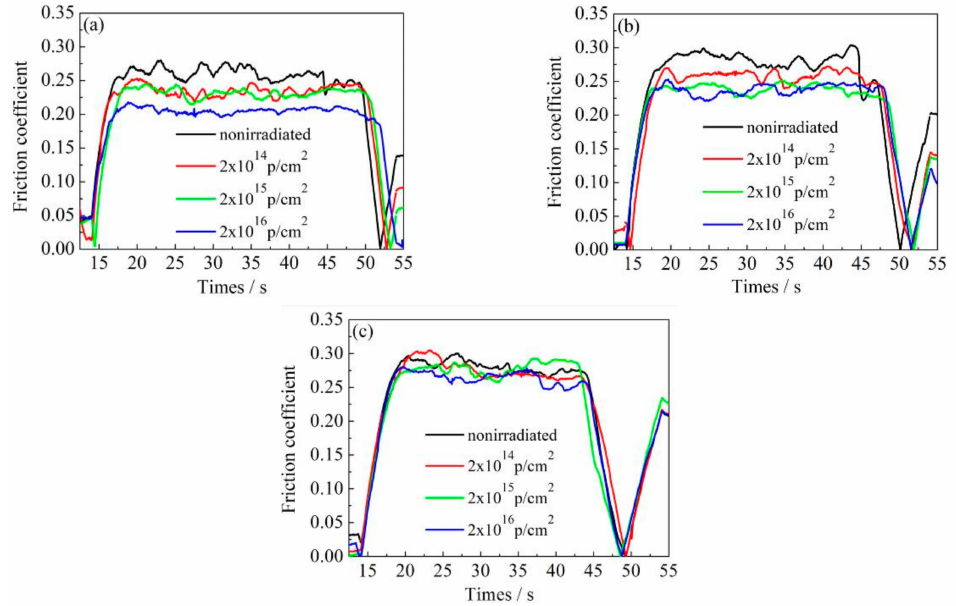
Figure 9. Friction coe ffi cient variations of 700 ◦ C-tempered AISI 420 steels after proton radiation with di ff erent cumulative charges. ( a ) 2000 µ N; ( b ) 3000 µ N; ( c ) 4000 µ N.